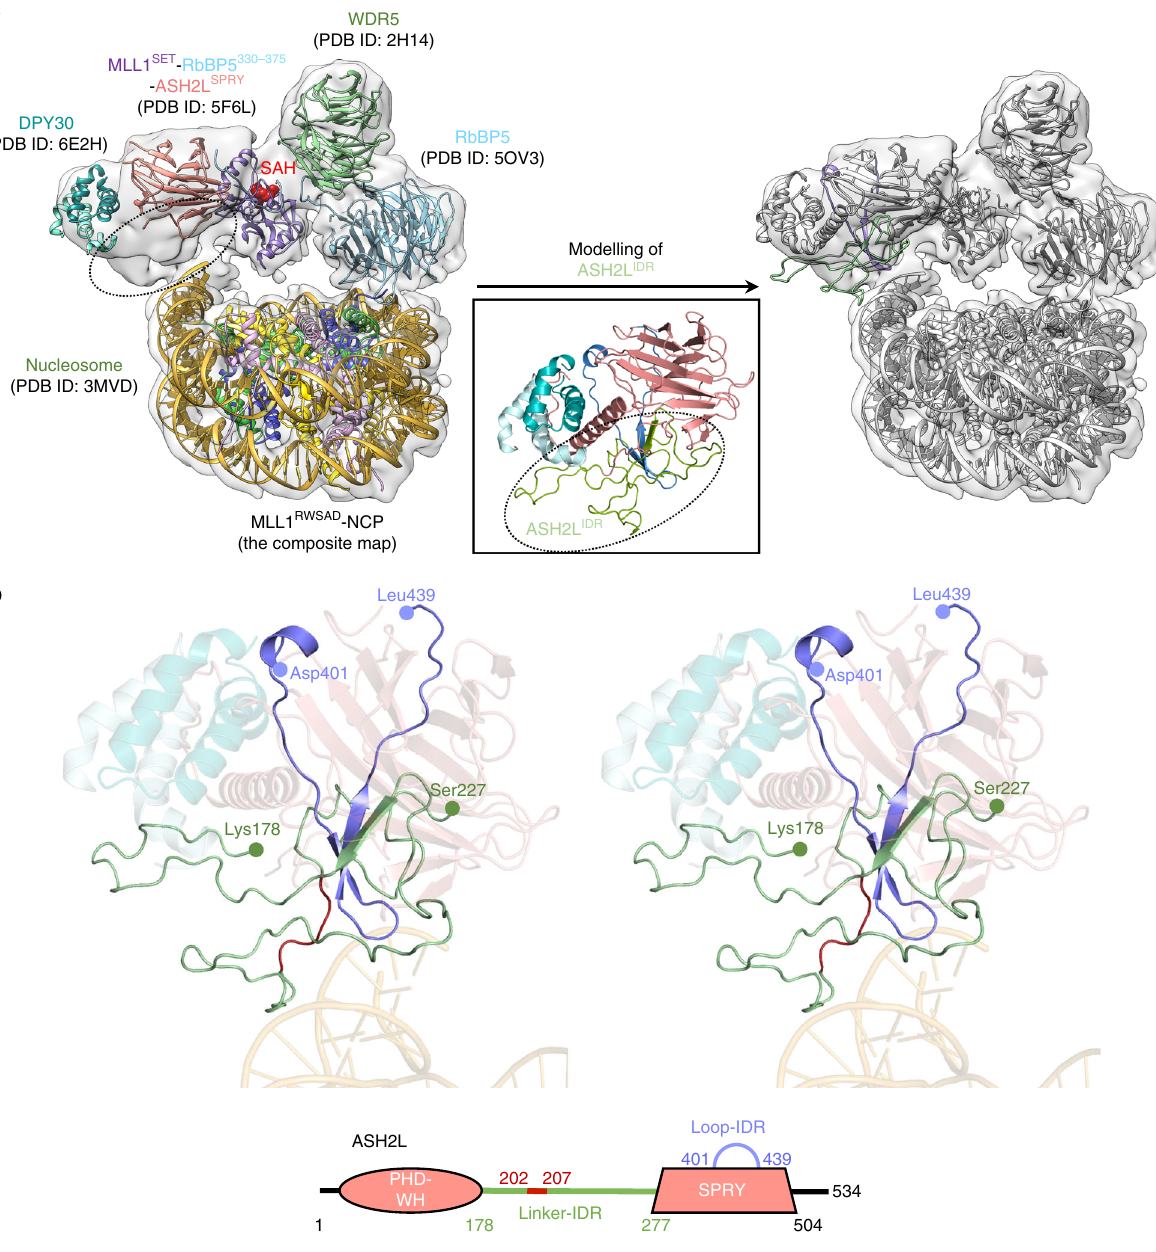
Fig. 4 ASH2L interacts with the nucleosomal DNA through IDRs. a Structure prediction of ASH2L IDR . The structure of ASH2L IDR regions was not available and thus not assigned in the corresponding cryo-EM map (dashed circle). The structure prediction approach was employed to model ASH2L IDR regions as described in the STAR methods. Linker-IDR colored green and Loop-IDR colored blue in the ASH2L IDR model structure. b Stereo-view of the ASH2L-DPY30 model structure and its contacts with DNA. The structure of ASH2L is a composite from crystal structure of ASH2L SPRY (PDB ID: 5F6L) 16 and the modeled ASH2L IDR . The schematics of ASH2L was shown at the bottom and key residues 202 – 207 in ASH2L IDR were highlighted in